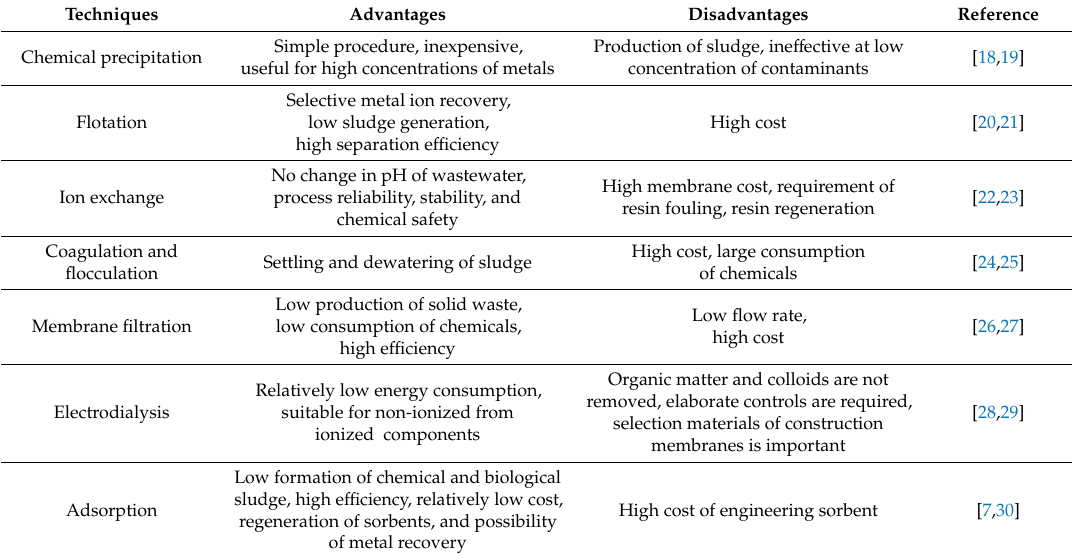
Table 1. Description of heavy metal removal